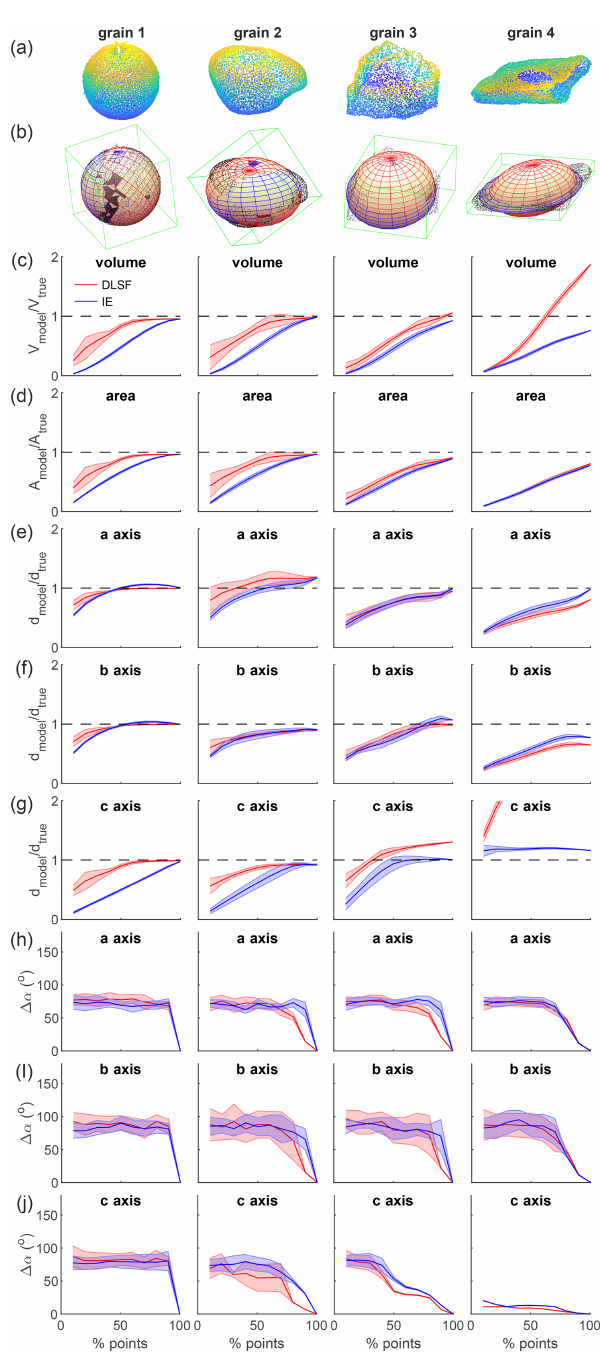
Figure 4. Influence of the grain surface covered by 3D data on the modeled ellipsoidal geometry of a grain. (a) Point clouds of the four tested grains, which consist of grains with increasing angularity and elongation from left (grain 1) to right (grain 4). (b) Resulting bounding box (green) and ellipsoid fit on each grain (black dots), using either the direct least-square fitting algorithm DLSF (red) or the inertia ellipsoid algorithm IE (blue). (c) Volume V and (d) surface area A of the modeled ellipsoids normalized by the volume and area of the convex hull of the point clouds of the entire grains, regarded as true estimates. Length of the modeled (e) a axis, (f) b -axis and (g) c axis normalized by the major, intermediate and minor length of the bounding box around the entire grain. Three-dimensional angle between the 3D vector of the (h) a axis, (i) b axis and (j) c axis with the orientation of the same vector resulting from the ellipsoid fitting the entire grain. In panel (c) to (j) , results obtained with the direct last-square fitting approach (DLSF) and the inertia ellipsoid approach (IE) are represented in red and blue, respectively. The error bar, given as a shaded surface around the mean value (solid line), is the standard deviation of the considered metrics obtained by changing 10 times the random